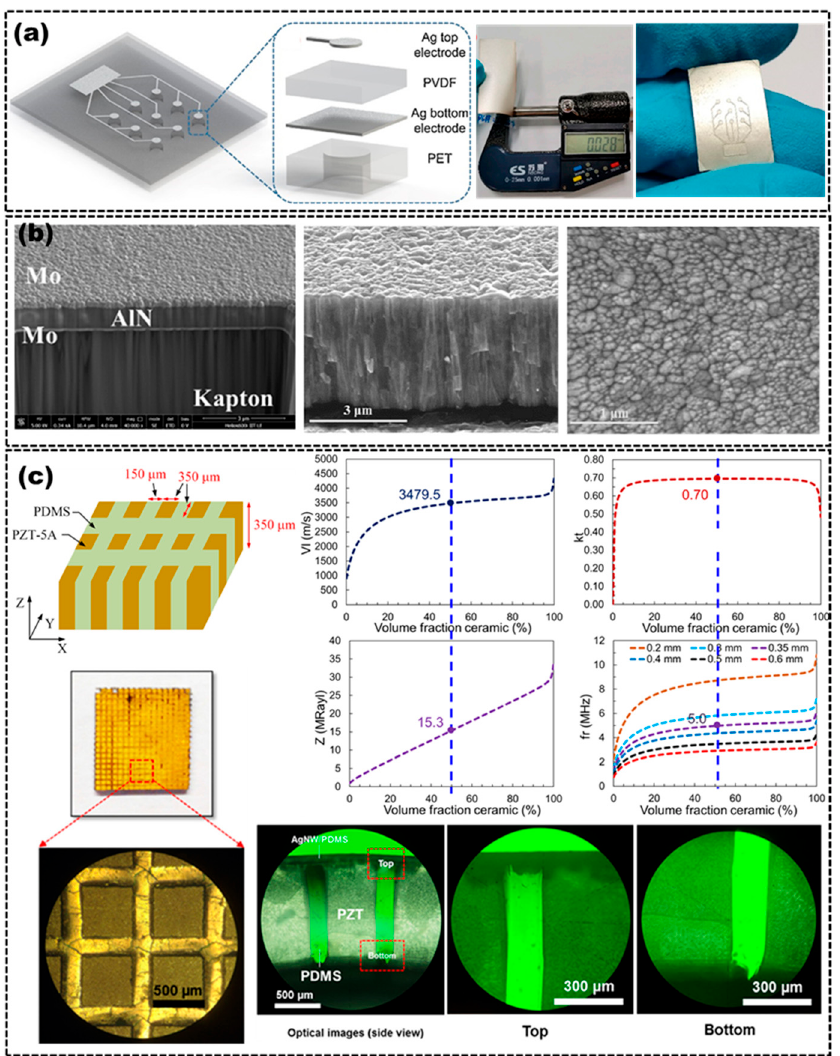
Figure 1. ( a ) Schematic of the cross-section of the transducer based on PVDF film ( left ), photograph of the PVDF ( middle ) and transducer ( right ). Adapted from [29,30]. ( b ) Scanning electron microscopy (SEM) images of the cross-section of the AlN film deposited on the substrate ( left ), cross-section of the ZnO film ( middle ) and surface of the ZnO film ( right ). Adapted from [19,27]. ( c ) Schematic diagram of the 1-3 piezocomposite ( top left ), curve of effective material properties of 1-3 piezocomposites with the volume fraction of PZT ( top right ), optical images of the 1-3 piezocomposite after deposition of the Au electrode ( left bottom ) and the interface between the PZT and PDMS ( bottom right ). Adapted from